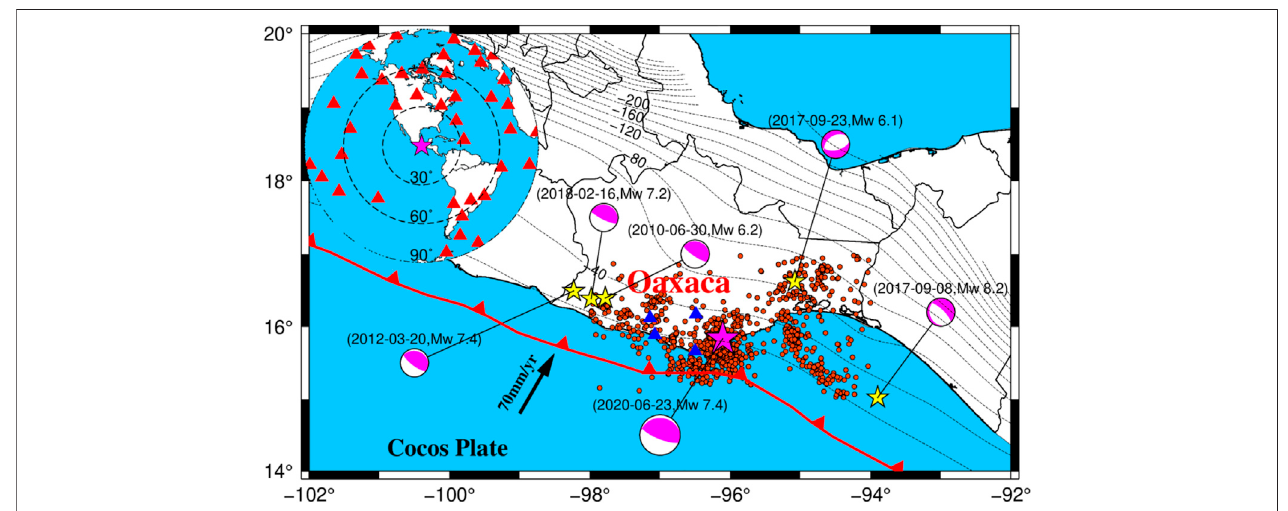
FIGURE 1 | Map of the epicentral region of the 2020 Oaxaca earthquake in the Mexican subduction zone; the yellow and magenta stars denote the epicentral locations of historical earthquakes which Mw > 6 since 2012 from the USGS earthquake catalogs and 2020 Oaxaca earthquake, respectively. The magenta beach balls denote the focal mechanism of each earthquake event. The dashed black contours denote slab surface depths from the slab 2.0 model (Hayes et al., 2018) with a contourintervalof20km.Theblueandredtriangles(upper-leftinsets)denotethe4high-rateGPSstationsand40teleseismicstationswithanepicenterdistanceof 30 ° ‒ 90 ° . The red circles denote the Mw ≥ 3.5 aftershocks a month after the 2020 Oaxaca